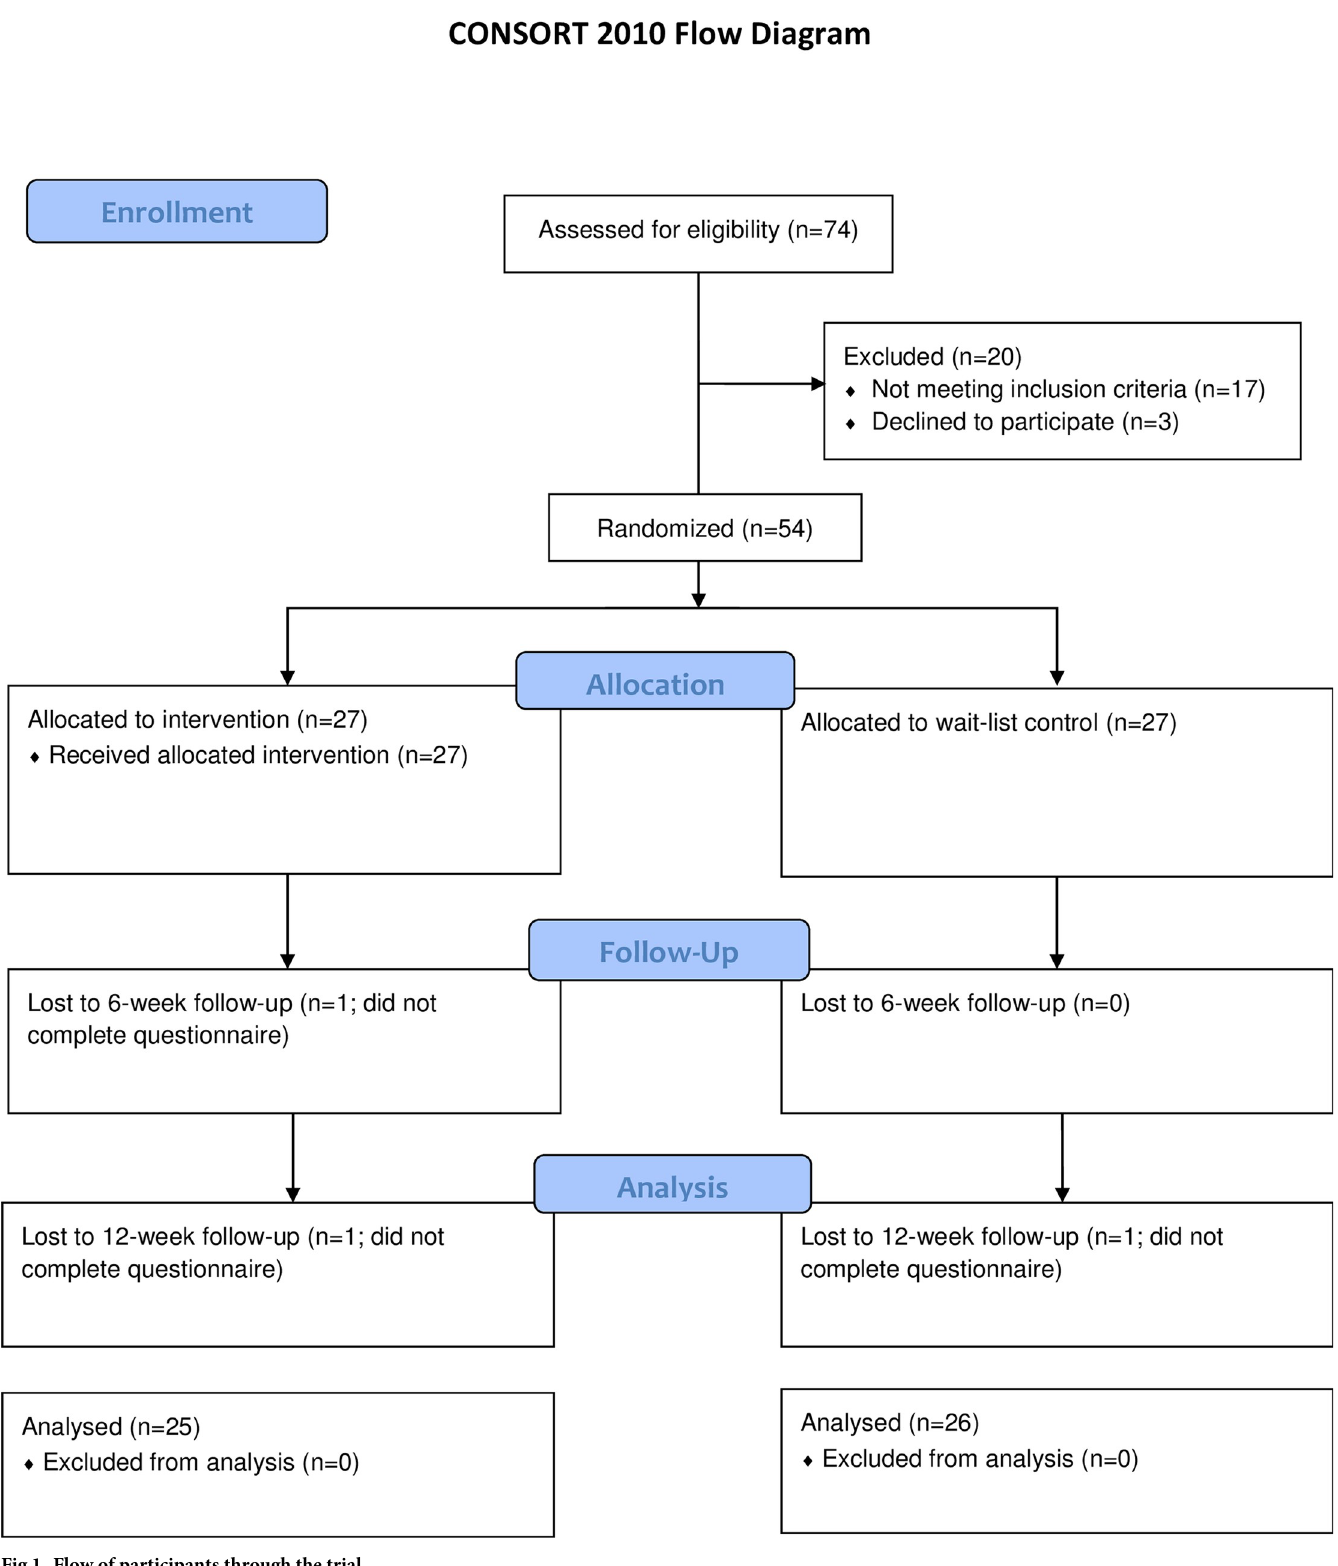
Fig 1. Flow of participants through the trial.